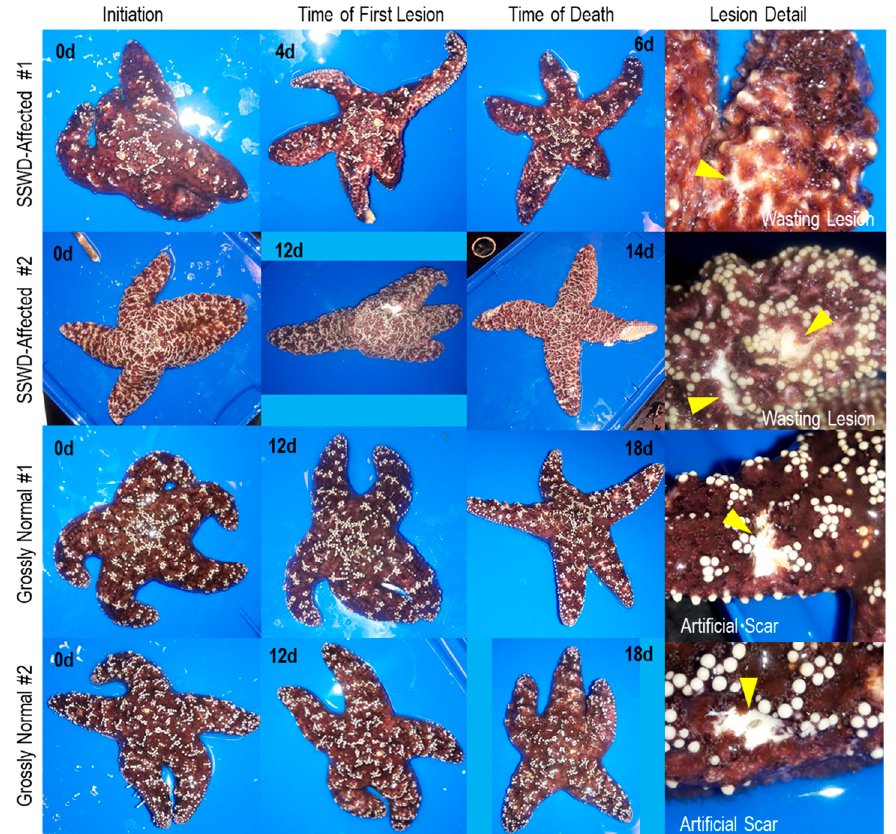
Figure 2. Gross changes in Pisaster ochraceus observed in specimens used in viral metagenome analyses over time, and detail (indicated by arrows) of wasting lesion and artificial scars sampled. The elapsed time is indicated on each panel.